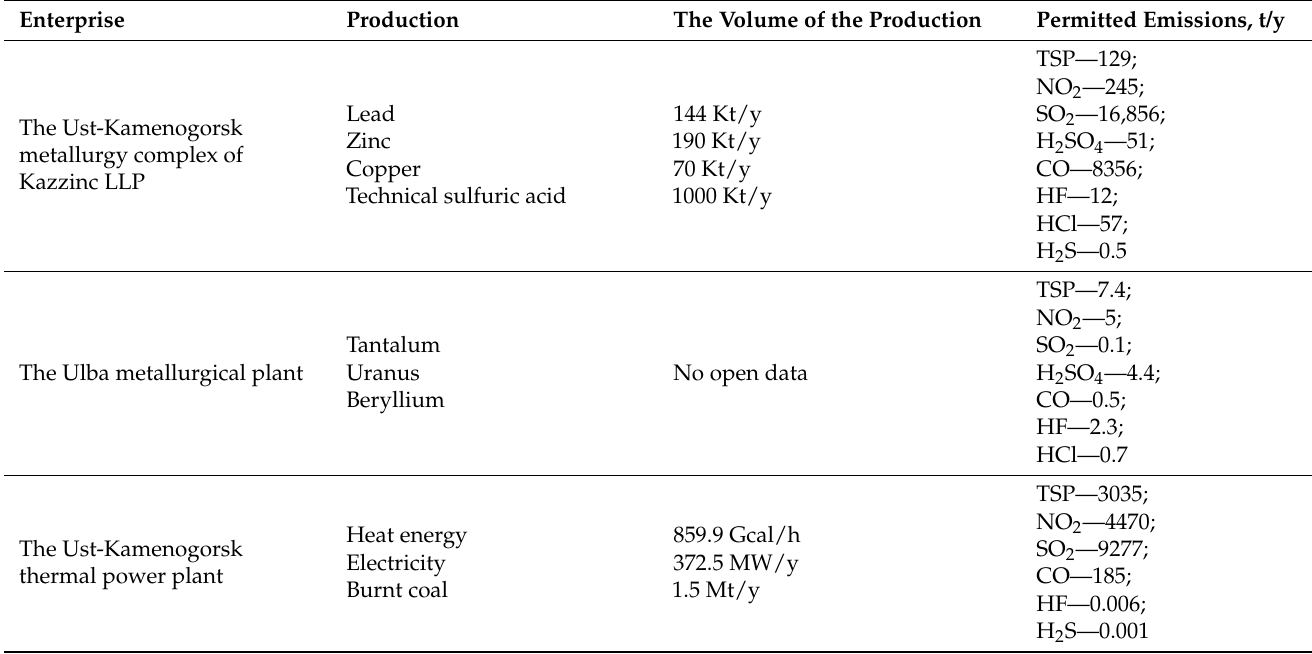
Figure 1. Map of the study area. Table 1. Characteristics of the industrial enterprises of